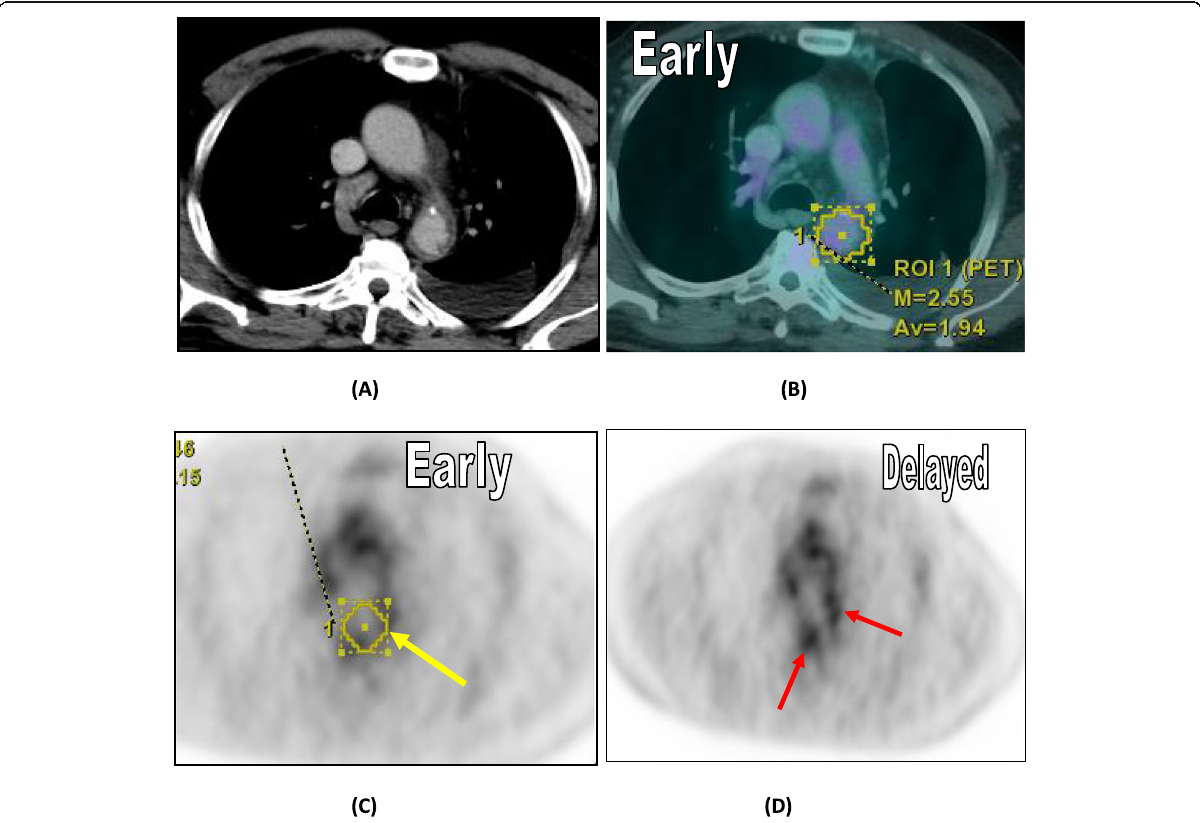
Fig. 1 Male patient 57-year-old, non-smoker, non-diabetic, non-hypertensive. He had a history of biliary obstruction with CBD stent underwent PET/CT for suspicious of abdominal malignancy. a Post contrast CT images showed diffuse irregular intimal thickening and small calcification ( b , c ) fused and PET early images showed measurement of SUVmax at the outer wall of the descending thoracic aorta (yellow arrow). d Delayed PET images showed increased FDG uptake with higher SUVmax (red